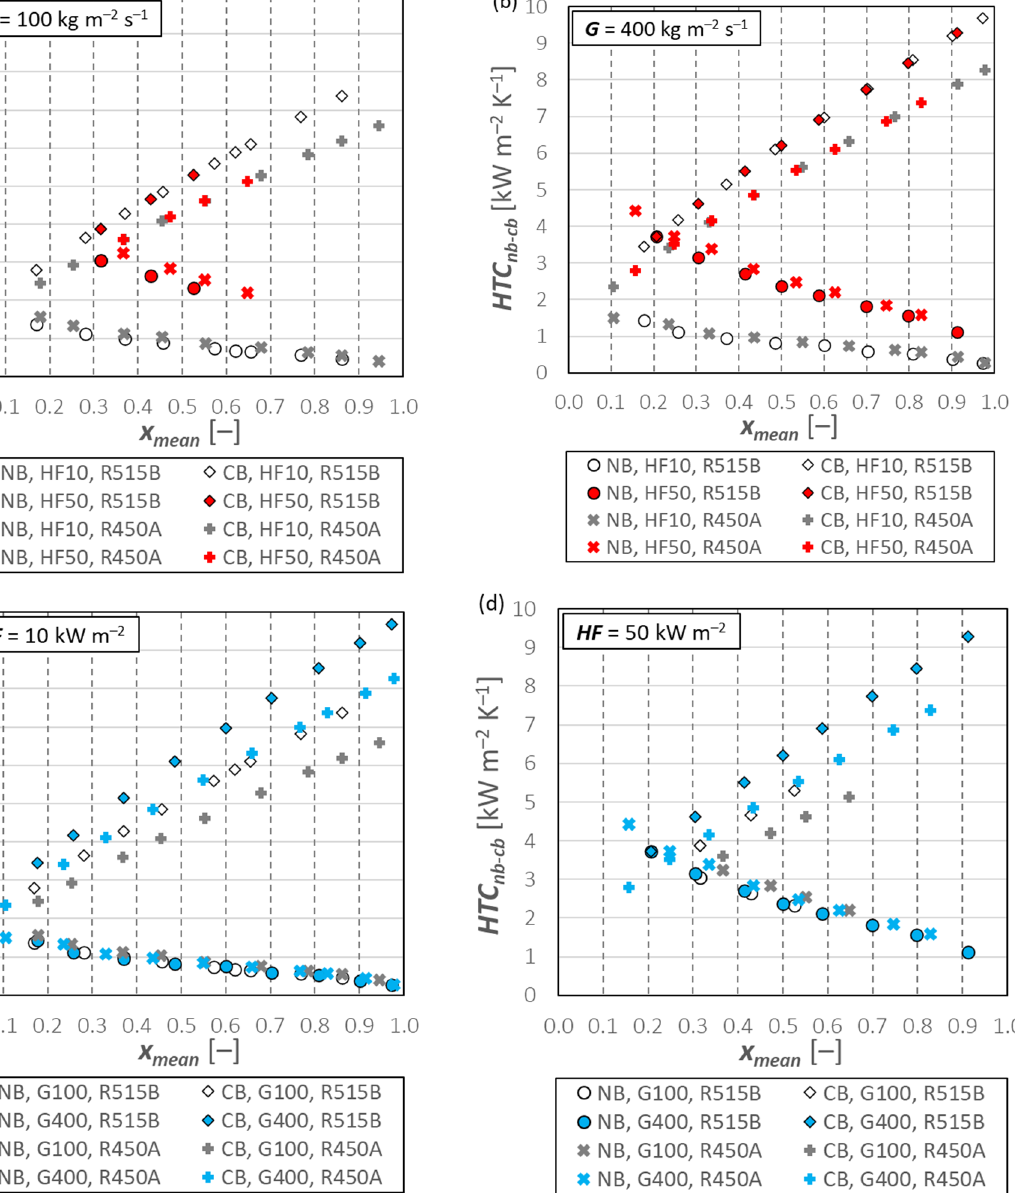
Figure 9. Contribution of nucleate boiling (NB) and convective boiling (CB) to the calculated heat transfer coefficient using the model by Diani et al. [39] at t sat =30 °C. HF10 = 10 kW m − 2 and HF50 = 50 kW m − 2 . G100 = 100 kg m − 2 s − 1 and G400 = 400 kg m − 2 s − 1 .